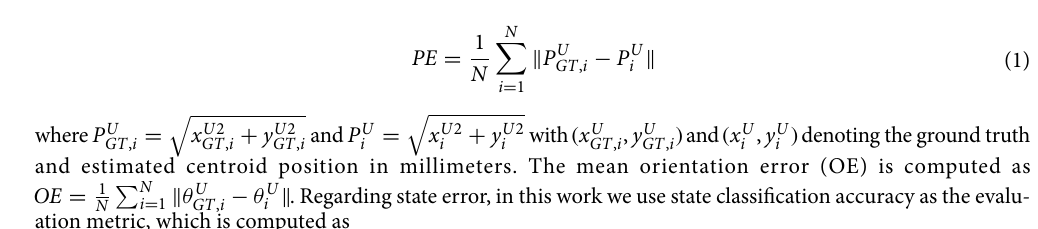
Figure 3. Hold-out test results for the mechanism state classification and 2D pose estimation. ( a ) shows the classification results for each status, ( b ) shows the error distributions of the 2D pose, and ( c ) are the sample test images for the status detection and 2D pose